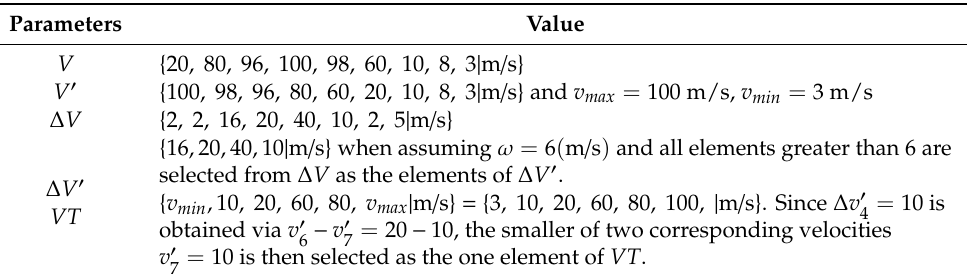
Table 1. Example of computing velocity partition